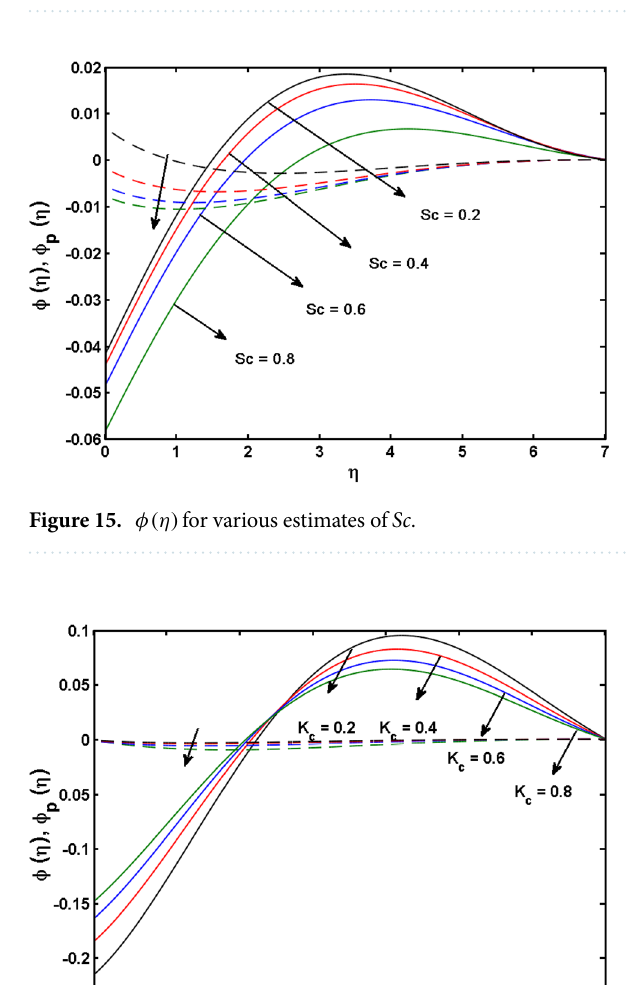
Figure 14. θ(η) and θ p (η) for various estimates of Q .